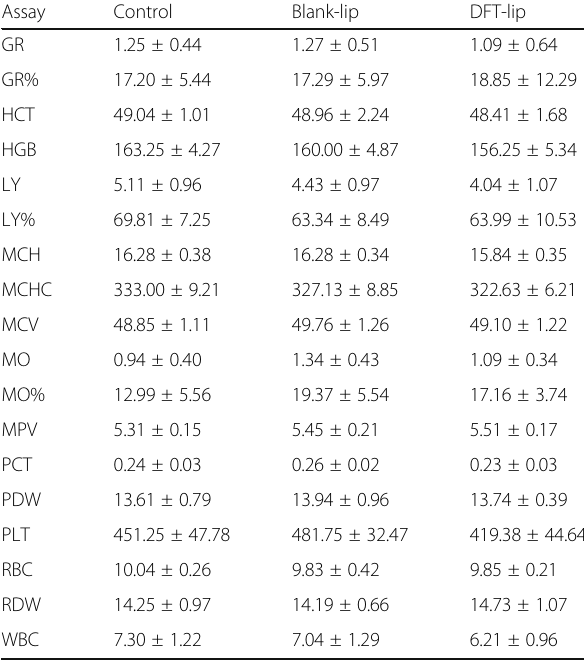
Table 2 Results of blood examination results from the retro- orbital sinus of mice after the administration of liposome